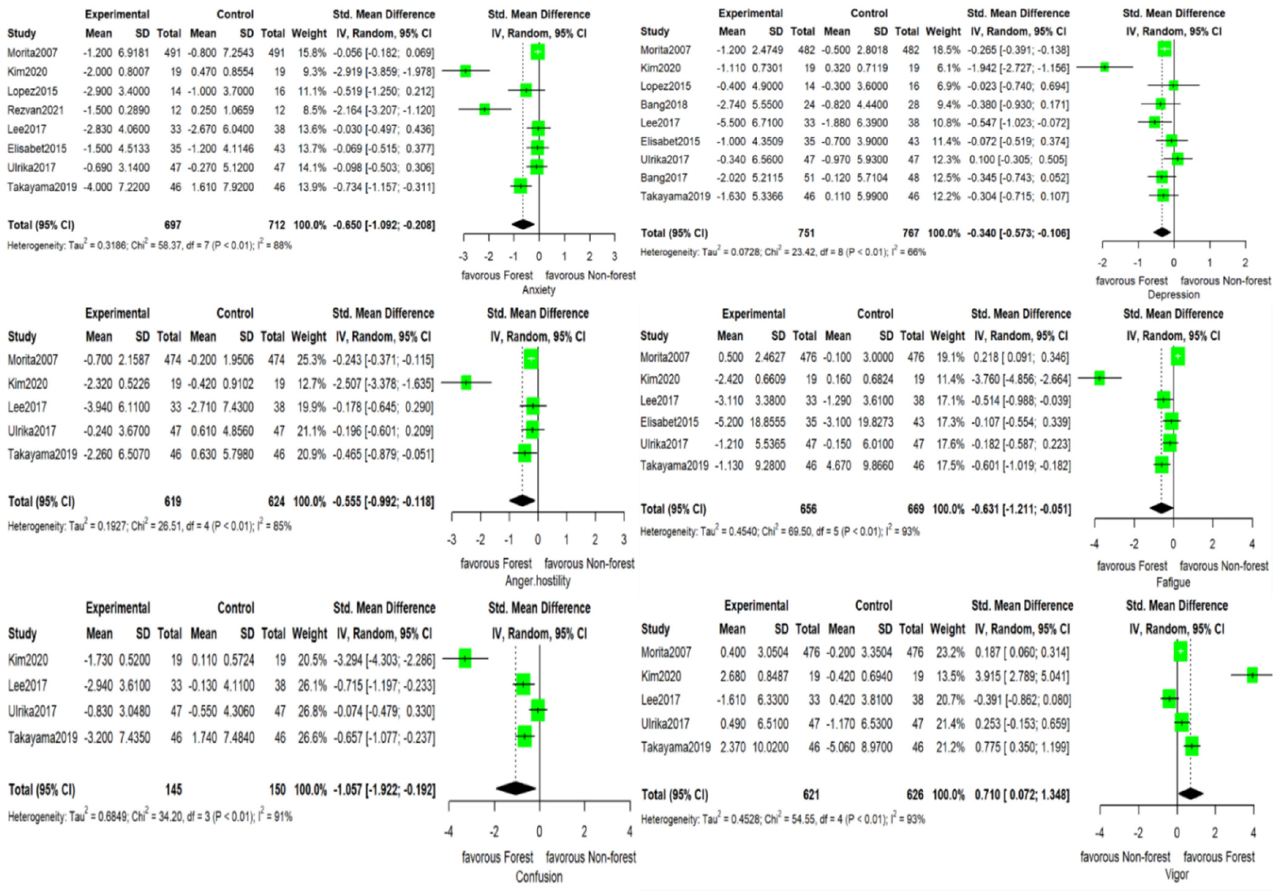
Figure 2. Forest plot of the results of a random-effects meta-analysis shown as mean differences in the POMS scores for psychological symptoms with 95% CIs. POMS, Profile of Mood States; CI, confidence interval; SD, standard deviation.